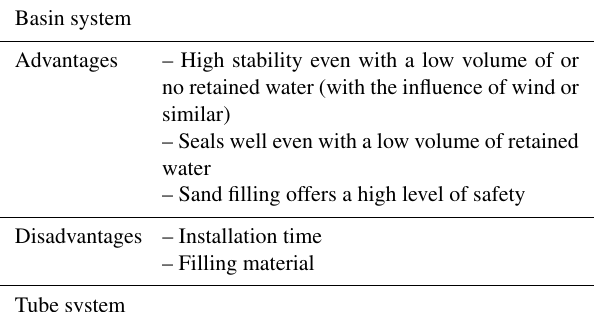
Table 2. Summary of the most important advantages and disadvan- tages of different system